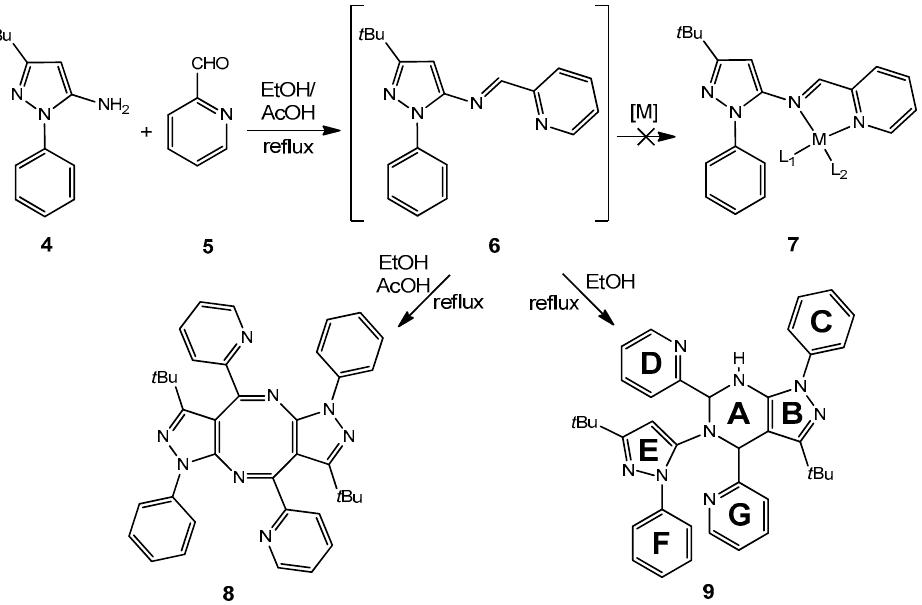
Figure 2. Synthetic scheme to produce novel 1,5-diazocine 8 or pyrimidine 9 derivatives by a dimerization process from 5-amino-3- tert -butylpyrazole 4 and 2-pyridinecarboxaldehide 5 . Capital letter labeling (in bold) in derivative 9 is used for clearer ring sorting.